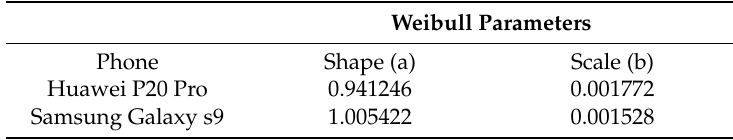
Table 6. Weibull parameters observed from each model comparison for distressed section 2.